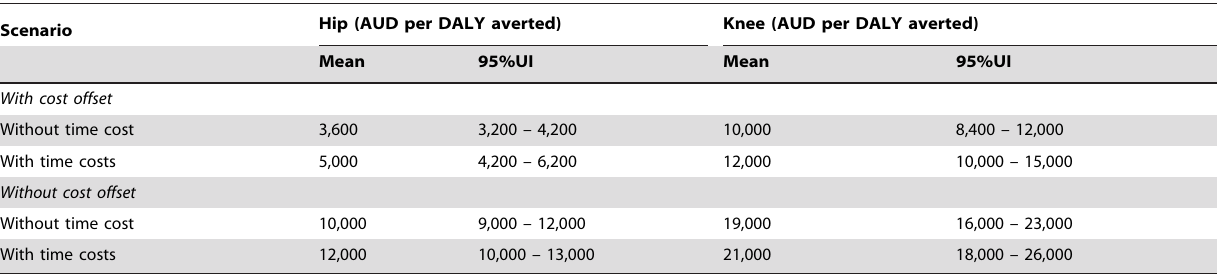
Table 8. Incremental cost-effectiveness ratio.